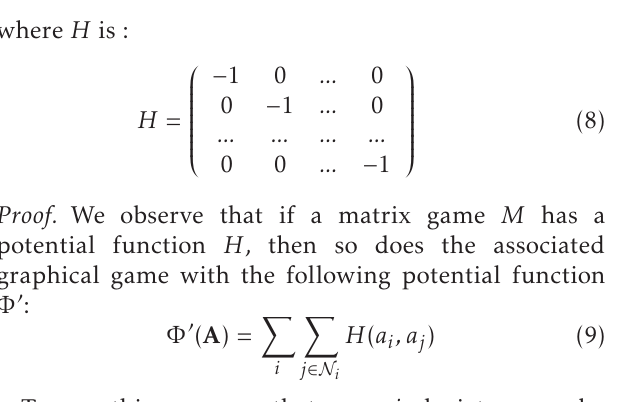
Figure 1. Simple example of a spectrum sharing graphical anti- coordination